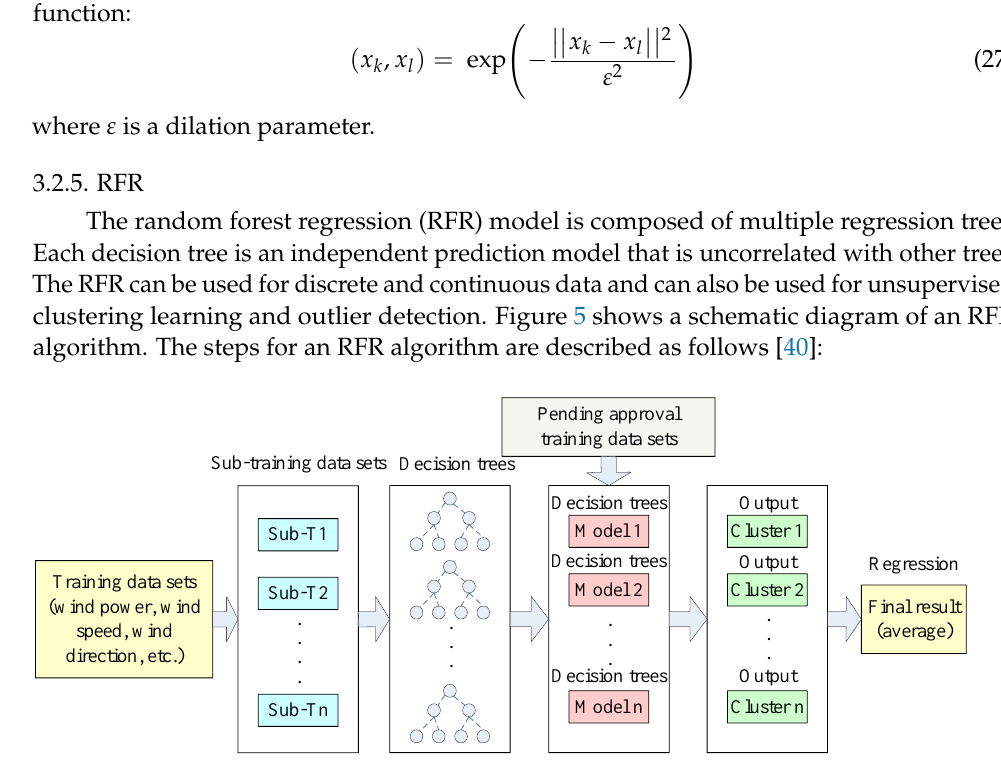
Figure 5. Schematic diagram of an RFR algorithm. Table 1. Comparison of the five single models. Method